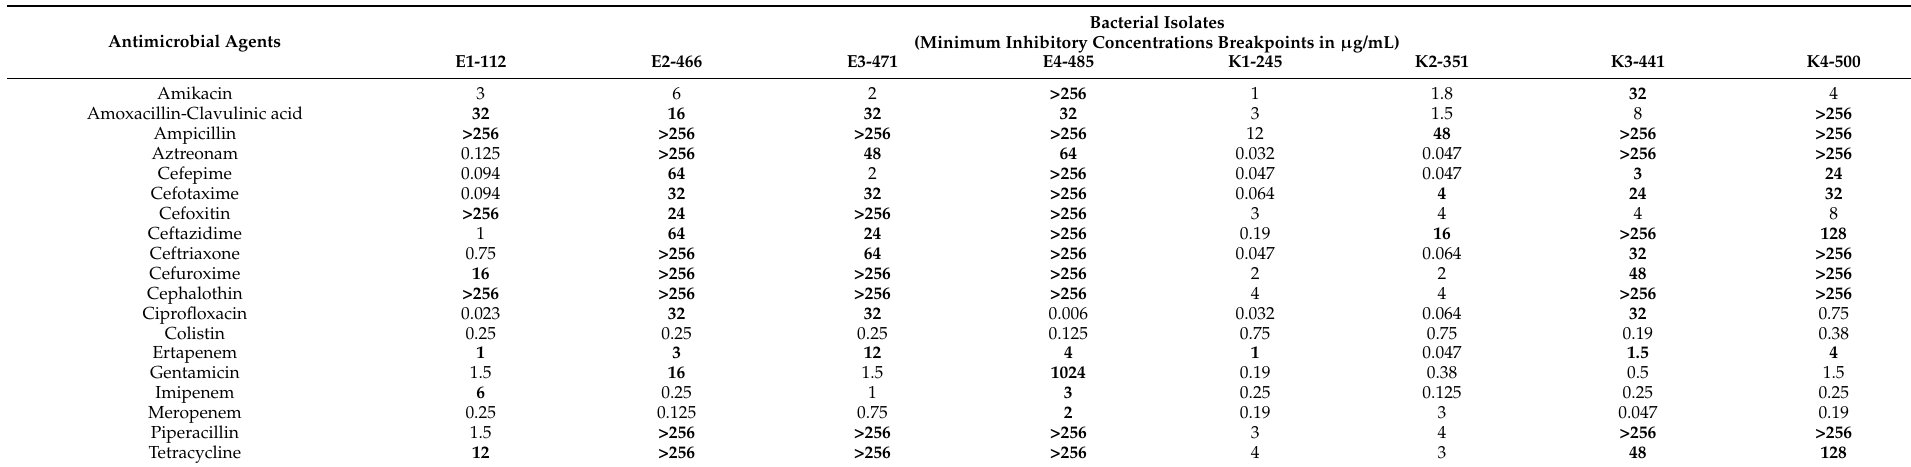
Table 2. Resistance pattern of Escherichia coli and Klebsiella pneumoniae isolates against selected antimicrobial agents. Antimicrobial Agents